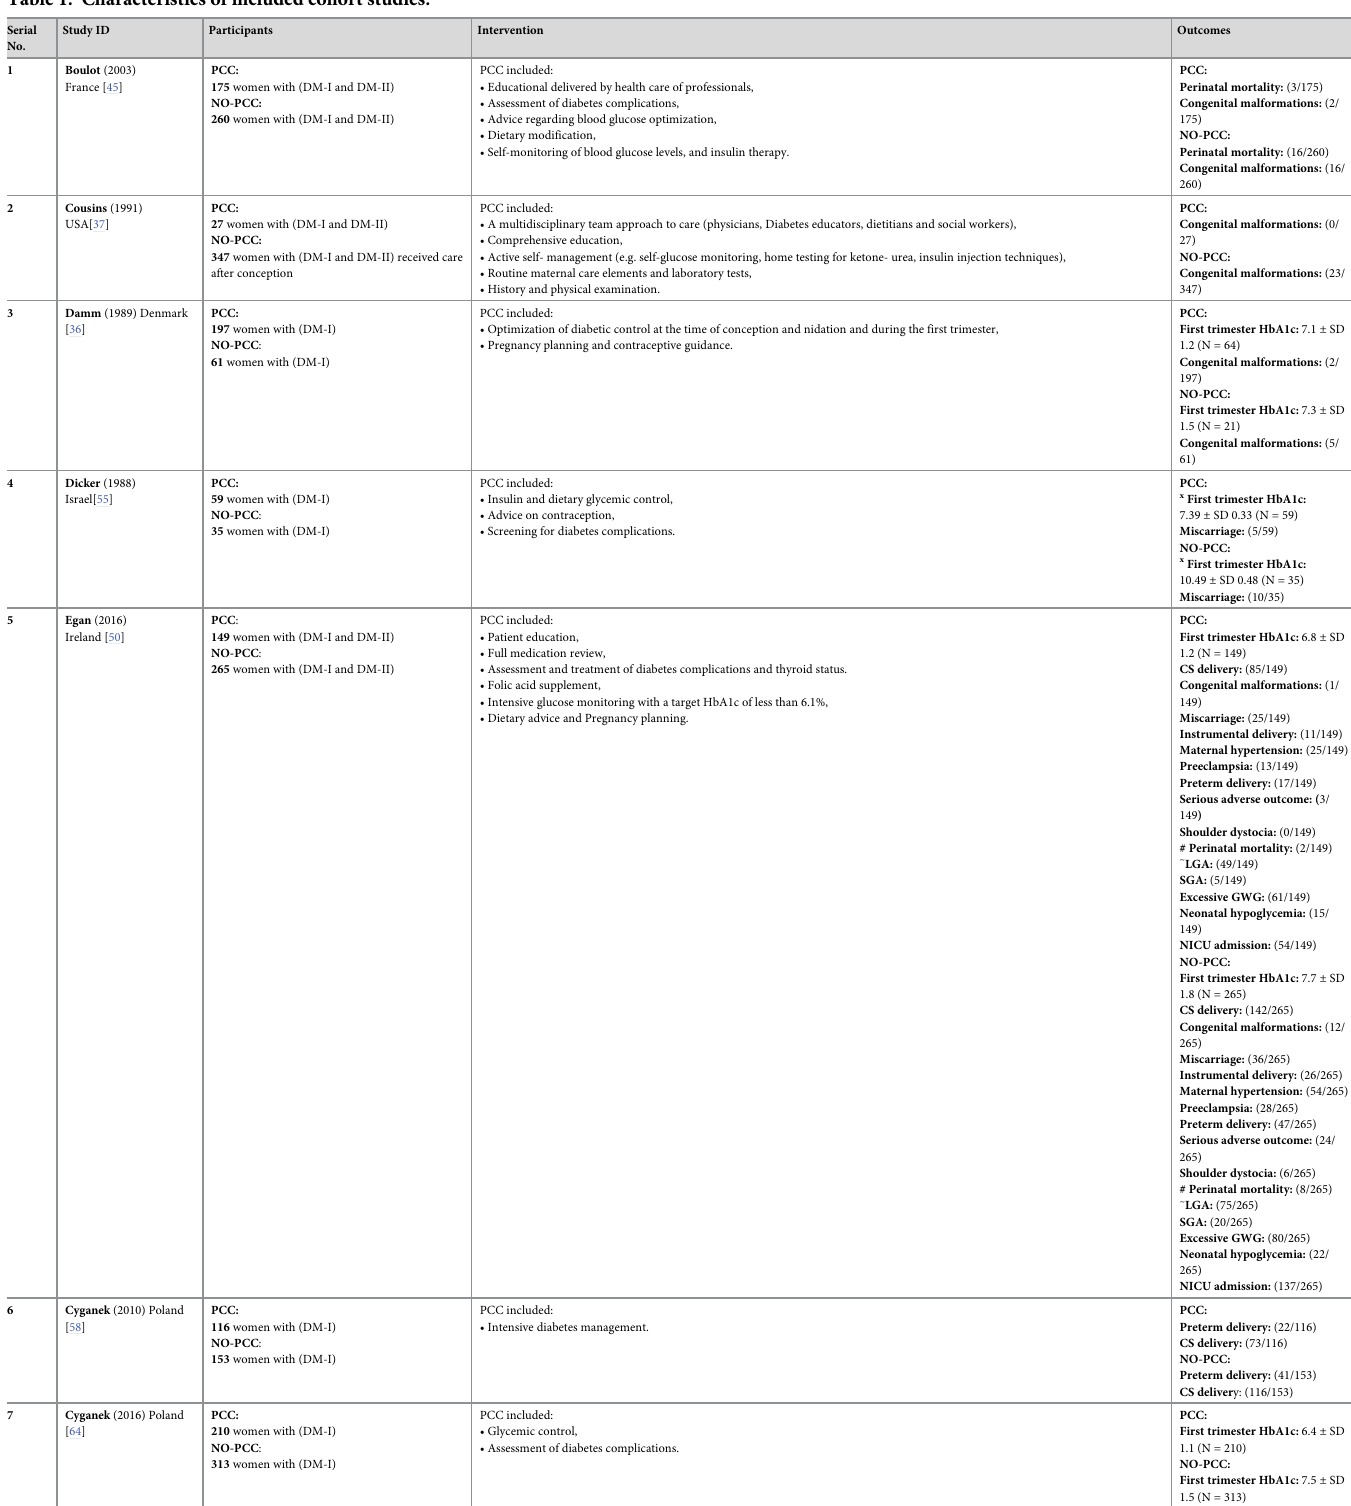
Table 1. Characteristics of included cohort